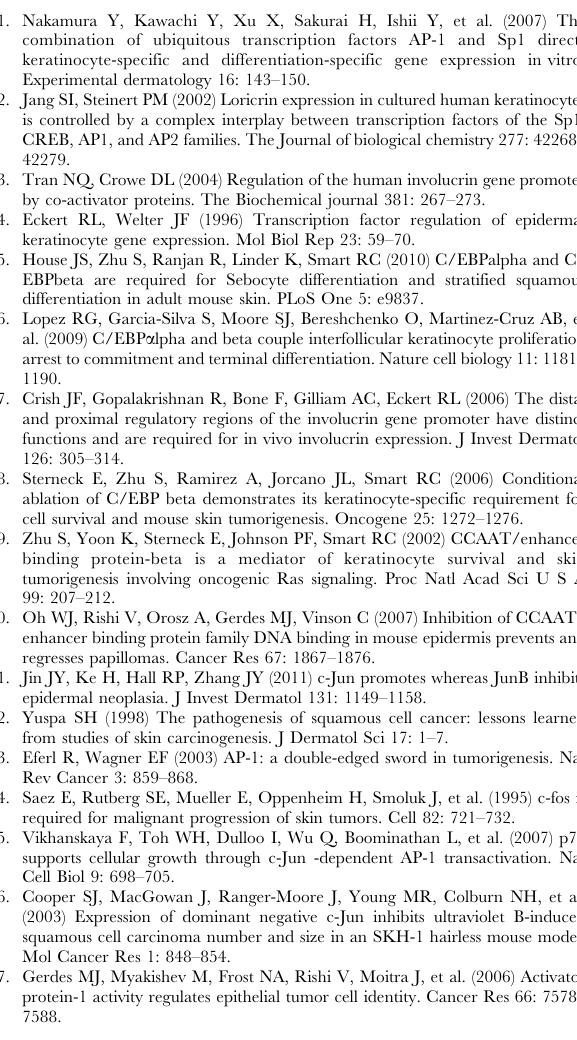
or unmethylated promoters is the same. Promoters bound by different combination of transcription factors are shown. Figure S7 Genes with promoters bound by C/EBP b and c-Jun are preferentially repressed by 5-azacytozine. Percent of genes which mRNA is repressed (white bars) or induced (black bars) by DNA demethylation agent 5-azacytidine in groups of promoters bound by different combinations of transcription factors in differentiated keratinocytes. * - significant difference p , 0.05. Figure S8 Combinatorial recruitment of CREB, C/ EBP a and c-Jun determines activation of promoters in keratinocyte differentiation. A. Scatterplot of C/EBP a binding v.s. C/EBP b binding show that C/EBOa was detected on a subset of promoters bound by C/EBP b . B. RNAP binding percentiles (15%, 50% and 85%) in promoters bound by different combinations of CREB, C/EBP a and c-Jun. C. Fraction of promoters bound by different combination of transcription factors in differentiated keratinocytes where RNAP binding is repressed (white bars) or induced by differentiation (black bars). D. Fraction of genes with mRNA levels induced or repressed by differentiation